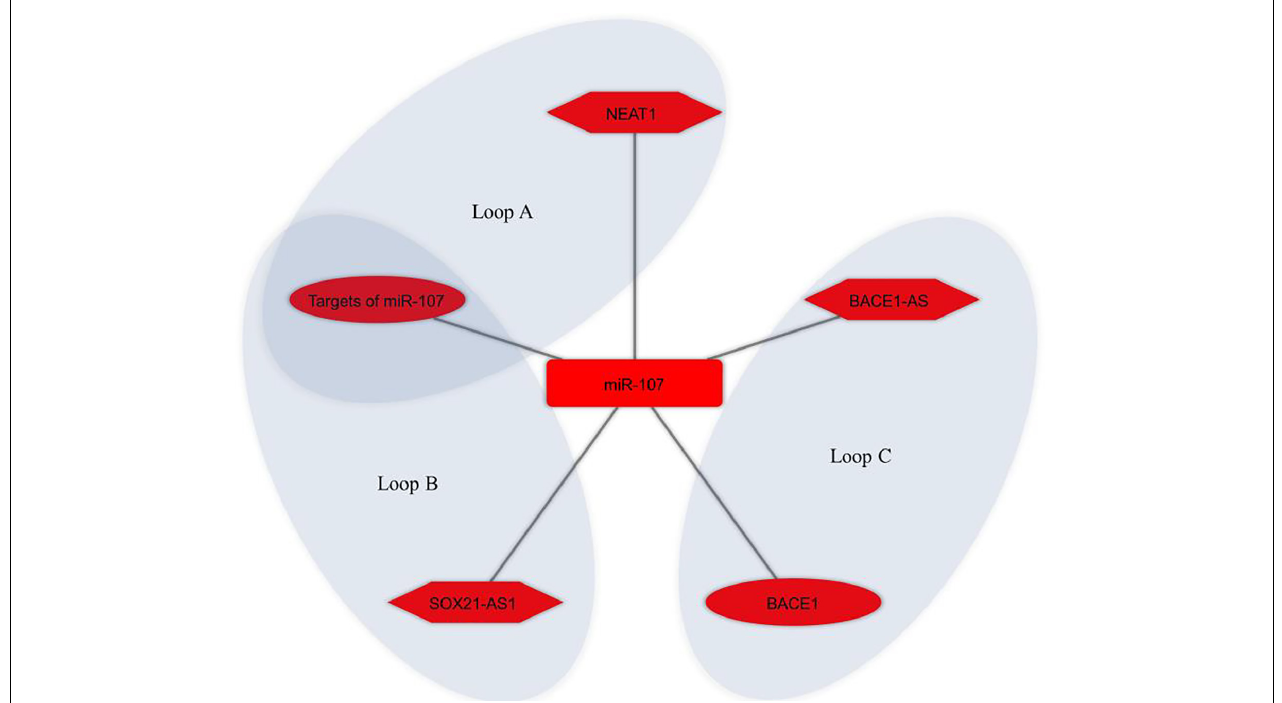
FIGURE 4 | miR-107 regulates different competing endogenous RNA (ceRNA) loops. Loop A ( NEAT1 and targets of miR-107 ), loop B ( SOX21-AS1 and targets of miR-107 ), and loop C ( BACE1-AS and BACE1 ) were all regulated by miR-107 . Red represents the damaging role of ceRNA axes. Lon non-coding RNAs, microRNAs, and mRNAs are represented by hexagon, round rectangle, and ellipse,